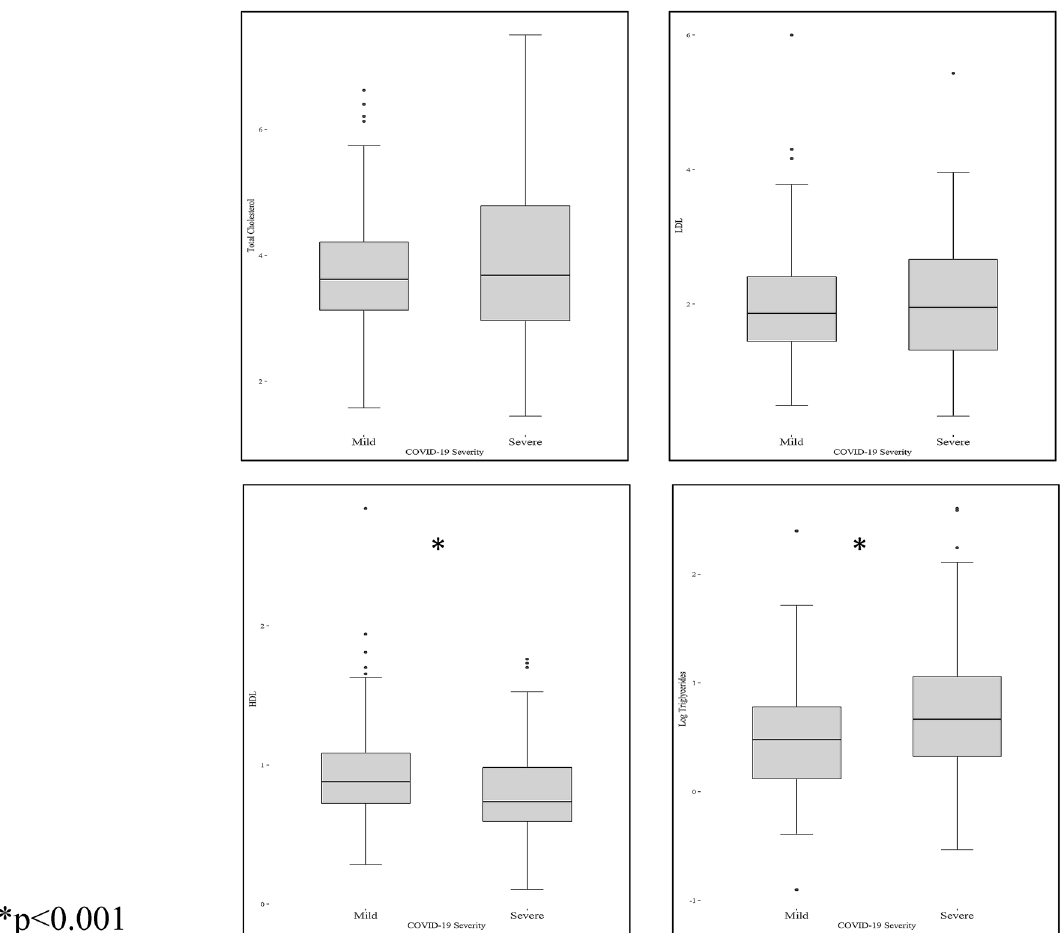
Figure 2. Box plot depicting lipid values obtained during COVID 19 hospitalization sorted according clinical